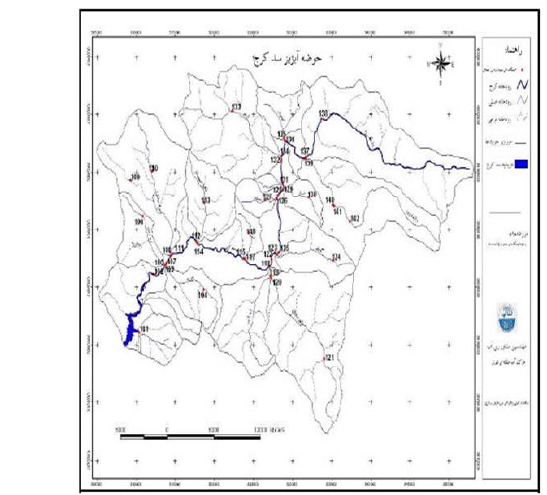
Figure 1. Amir kabir